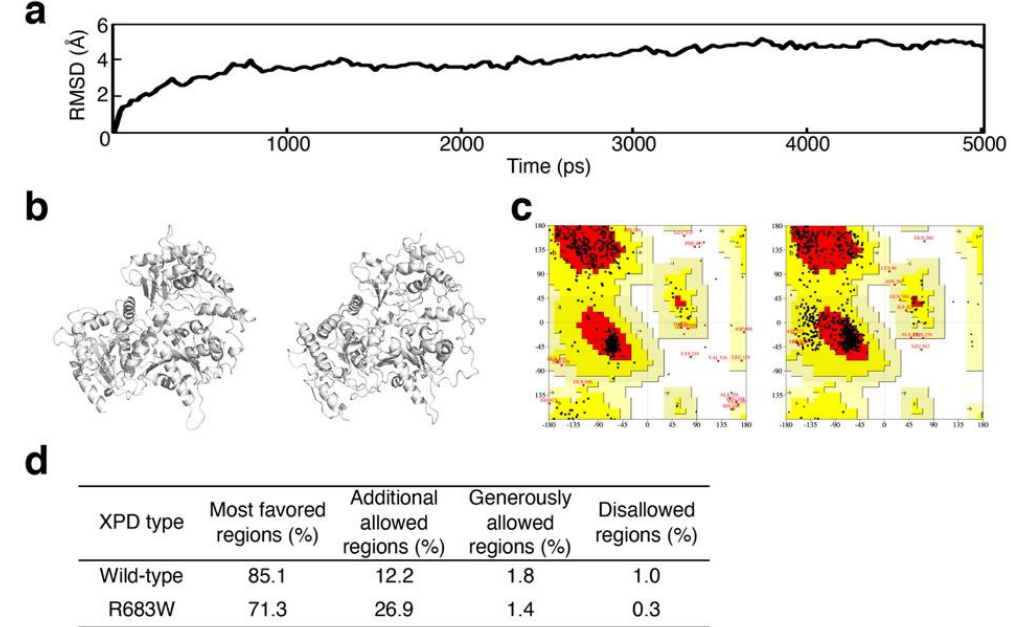
Figure 2. Validation of the 3D structures of wild-type XPD and XPD R683W. ( a ) The root-mean-square deviation (RMSD) for the backbone atoms of XPD R683W is shown as a function of time. ( b ) Cartoon representations of 3D structures of wild-type XPD (left) and XPD R683W (right). ( c ) Ramachandran plots for wild-type XPD (left) and XPD R683W (right). ( d ) Plot statistics for each XPD type.